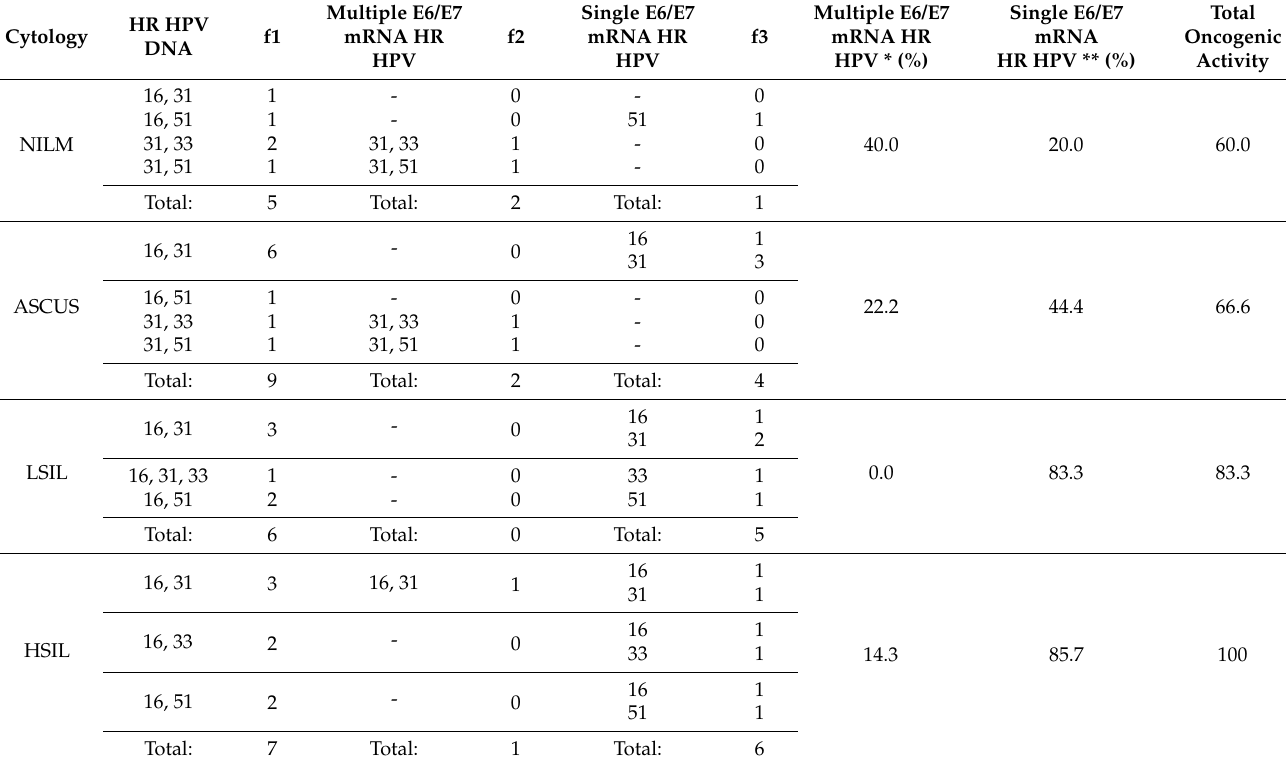
Table 8. Analysis of the oncogenic activity of multiple infections of the most prevalent HR